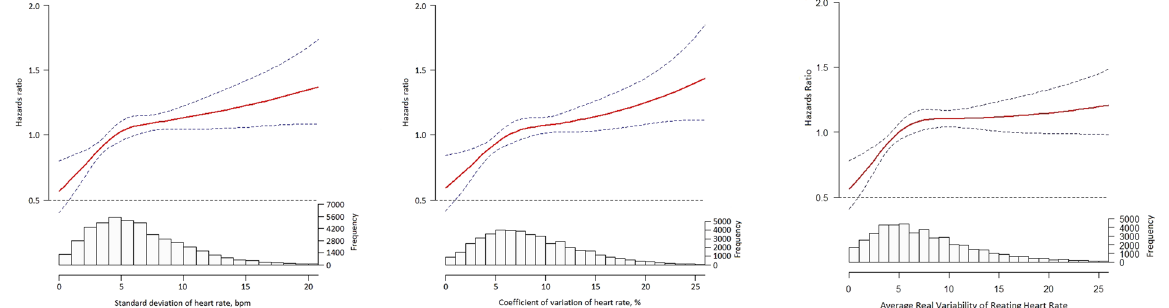
Figure 3. Association between standard deviation (left panel), coefficient of variation of resting heart rate (middle panel), and average real variability (right panel) with all-cause mortality over a median of 49.4 months